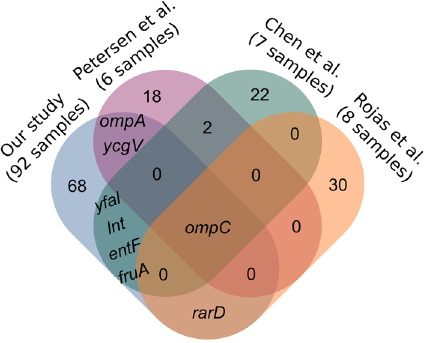
Figure 2. Venn diagram of common genes between previous studies as well as our study. The number in the figure refers to the count of genes. However, for the common genes between our study and previous studies, we showed the name of genes instead of their count. We found eight genes ( ompC , ompA , ycgV , rarD , yfaL , lnt , entF , and fruA ) in common with previous studies of positive selection in E. coli . The ompC gene, which is known to be under positive selection in bacteria, is common to all